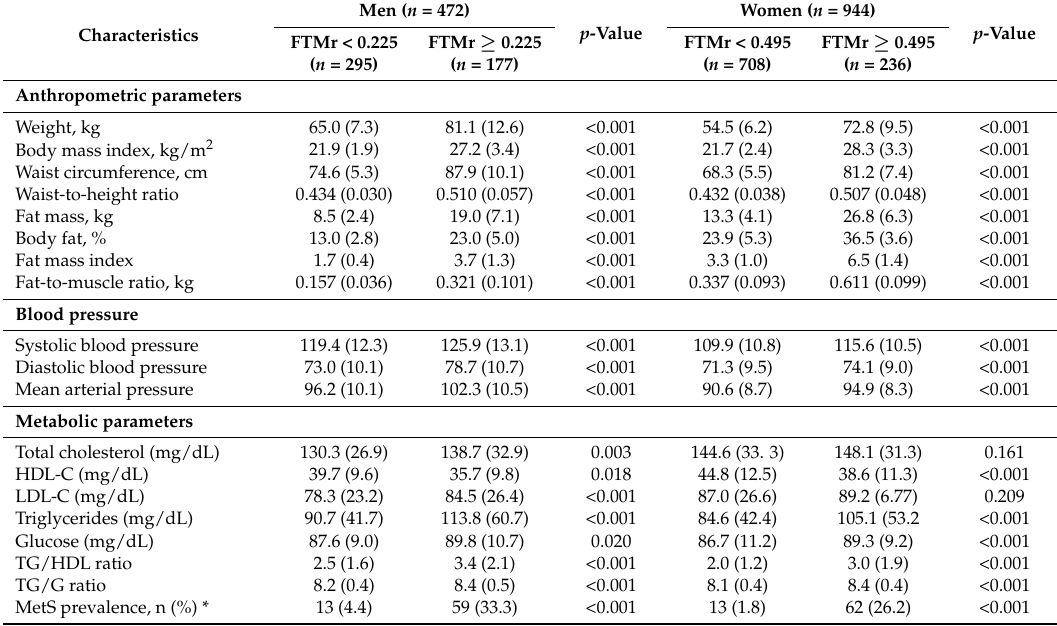
Table 3. Sex thresholds of ratio of fat mass to muscle mass to detect high risk of MetS according to the International Diabetes Federation (IDF), for anthropometric, blood pressure, metabolic biomarker parameters, and